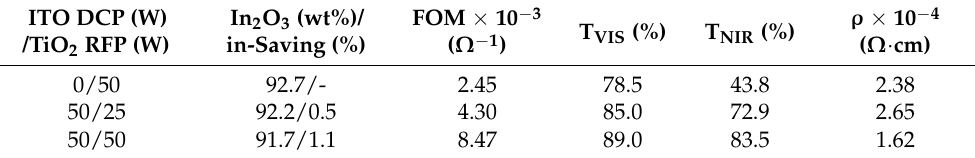
Table 8. FOM and average T NIR values capability as function of the sputtering conditions used. The In 2 O 3 concentration, the amount of In ‐ saving and the resistivity of the films are also included. ITO DCP (W) FOM × 10 − 3 In 2 O 3 (%wt)/ /TiO 2 RFP (W) in ‐ Saving (%)